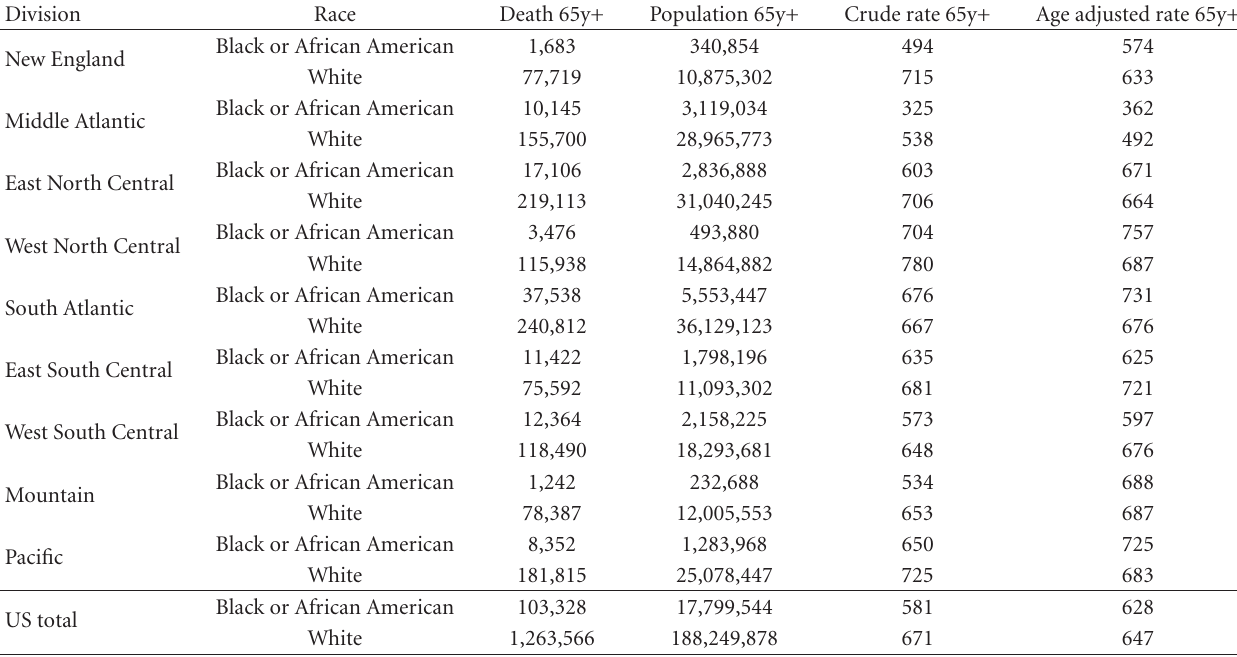
Table 1: Number of deaths, population, and rate of death per 100,000 with underlying or contributing cause coded as dementia by division and race in persons aged 65 and over: United States